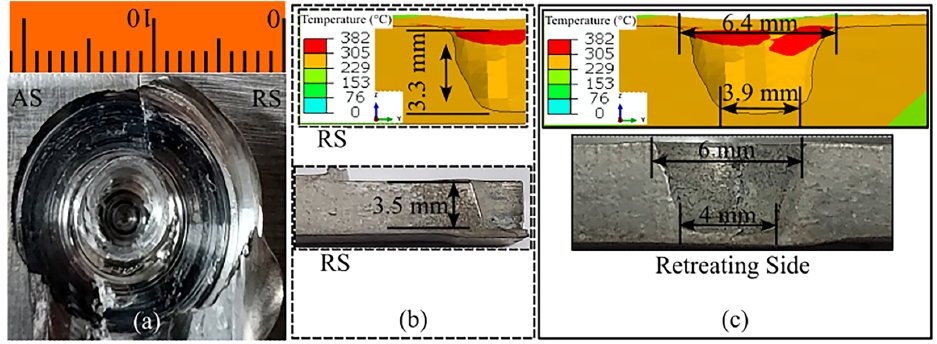
Figure 7. The experimental and numerical investigation of the exit hole: ( a ) experimental result, ( b ) height, and ( c ) cross-sectional variations in the solution domain.